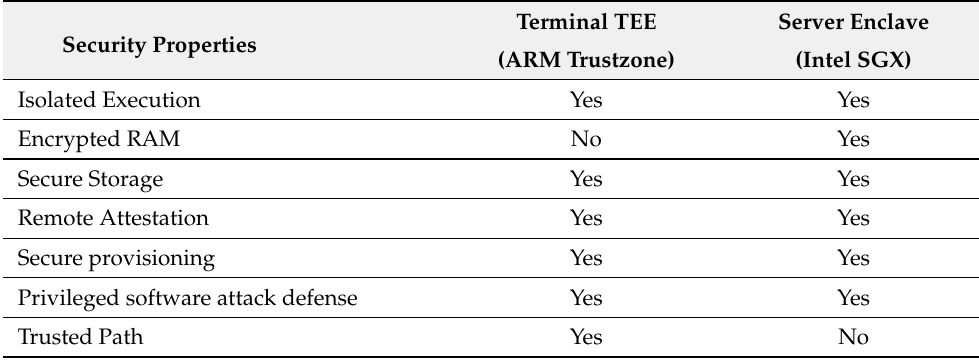
Table 11. Security Properties of Terminal TEE and Server